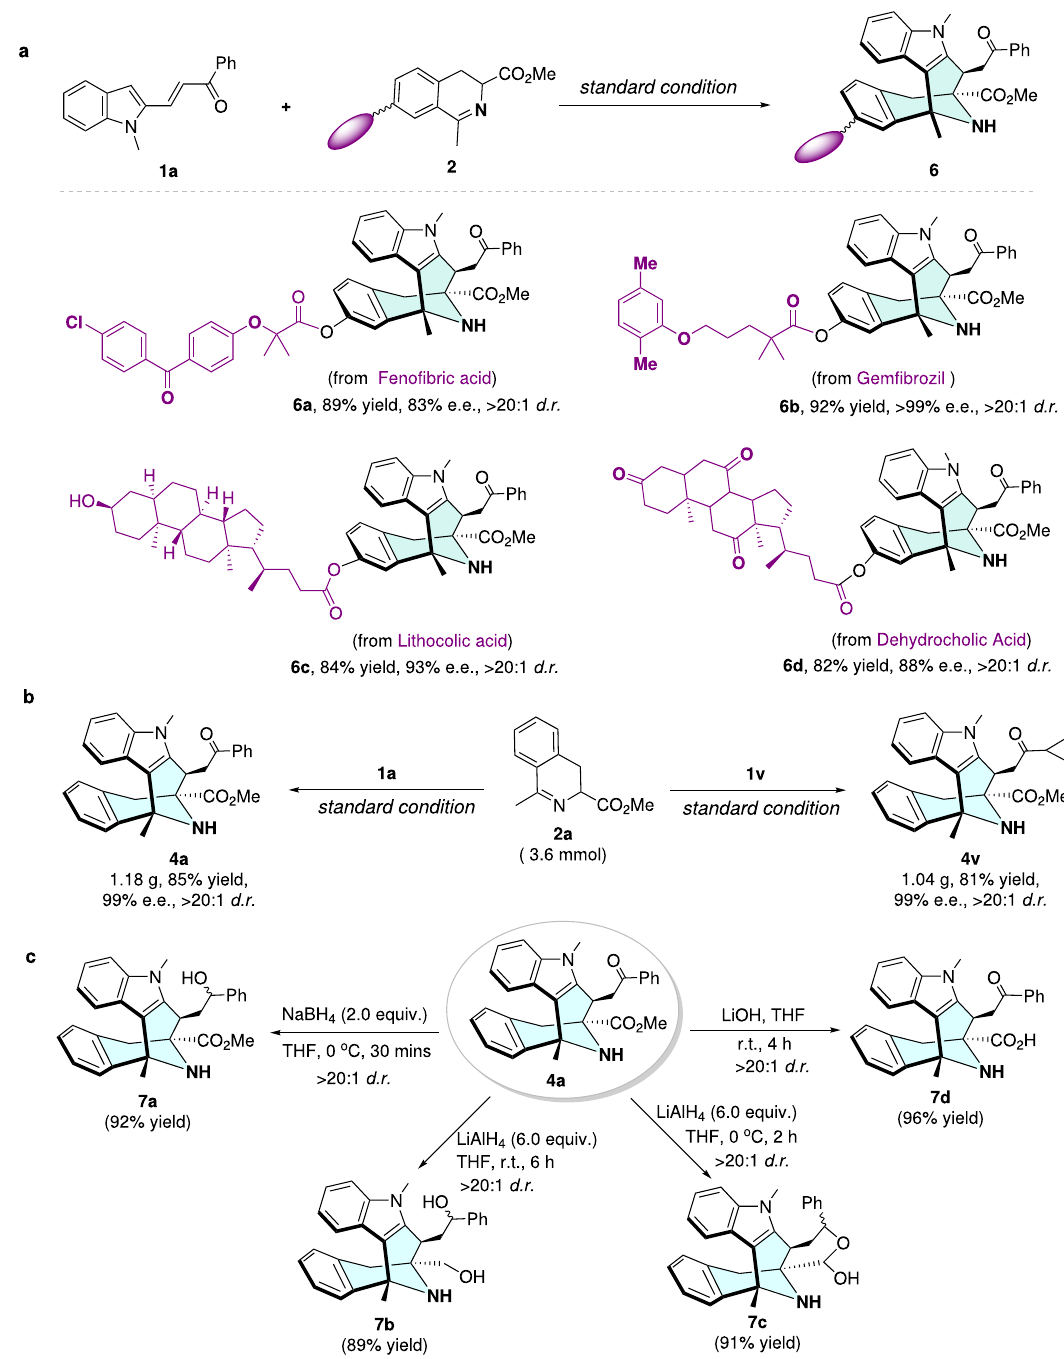
Fig. 6 Synthetic applications. a Late-stage diversi fi cation. b Gram-scale preparations. c Product